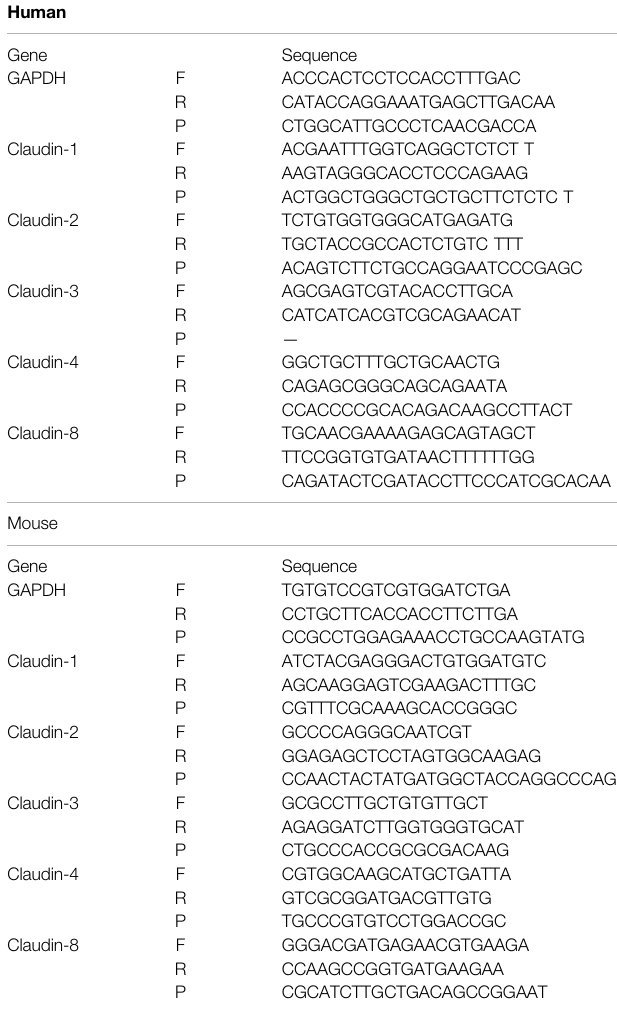
TABLE 1 | Sequences of primers and probes used for